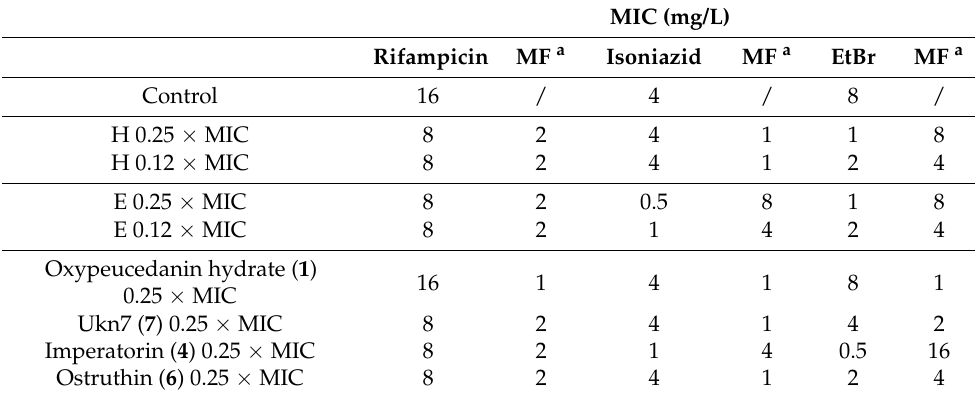
Table 3. Minimal inhibitory concentration (MIC, mg/L) of rifampicin, isoniazid, and ethidium bromide (EtBr) alone, and in the presence of P. ostruthium hexane (H) and ethanolic (E) extracts at 0.25 × MIC (7.82 mg/L) and 0.125 × MIC (3.91 mg/L), and coumarins oxypeucedanin hydrate ( 1 ), unknown compound 7 (Ukn7), imperatorin ( 4 ), and ostruthin ( 6 ) at 0.25 × MIC, as resistance modulators of M. smegmatis mc 2 155 with the corresponding resistance modulation factor (MF) showing an increase in antibiotic activity in the presence of